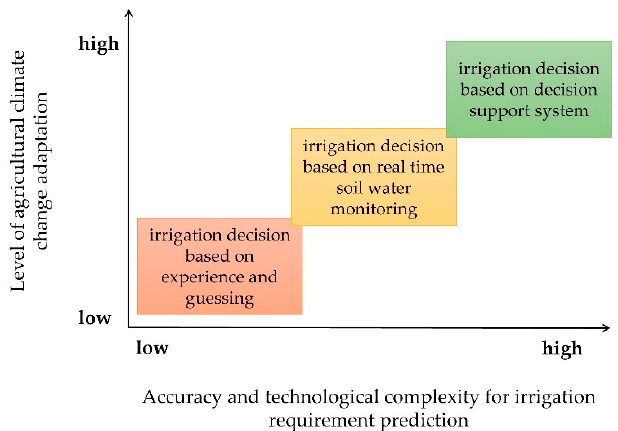
Figure 4. Degree of agricultural climate change adaptation defined in terms of the technological complexity required to predict irrigation requirements.